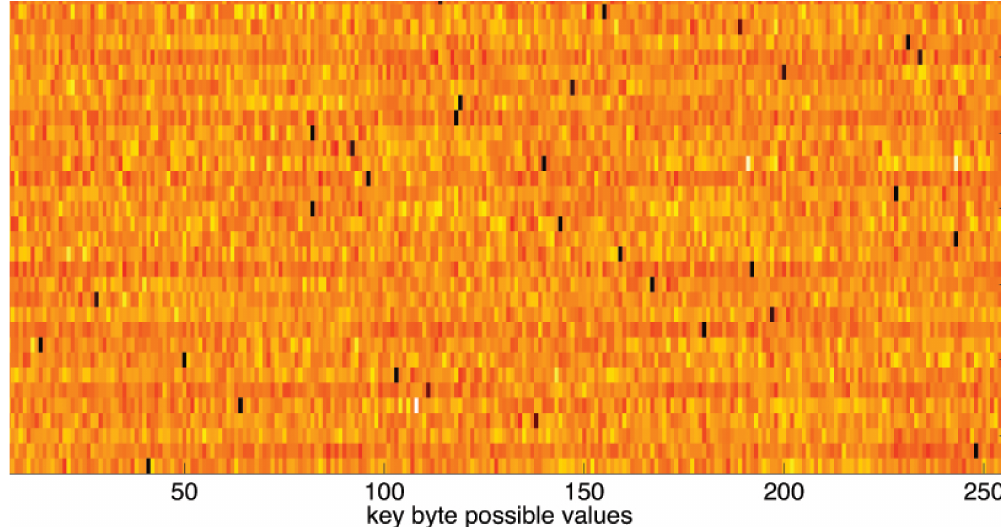
Figure 5. Color map of discarding scores distribution for the 32 bytes of the key retrieved with the Flush+Reload technique. Correct key values are the darkest